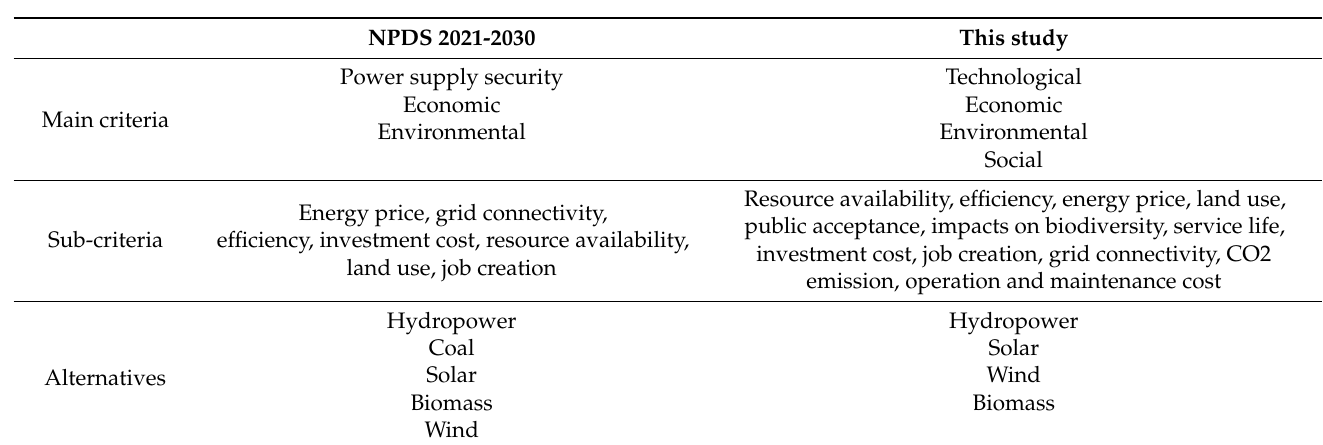
Table 3. Comparison between the criteria and alternatives of energy resources in the NPDS 2021-2030 and this study.